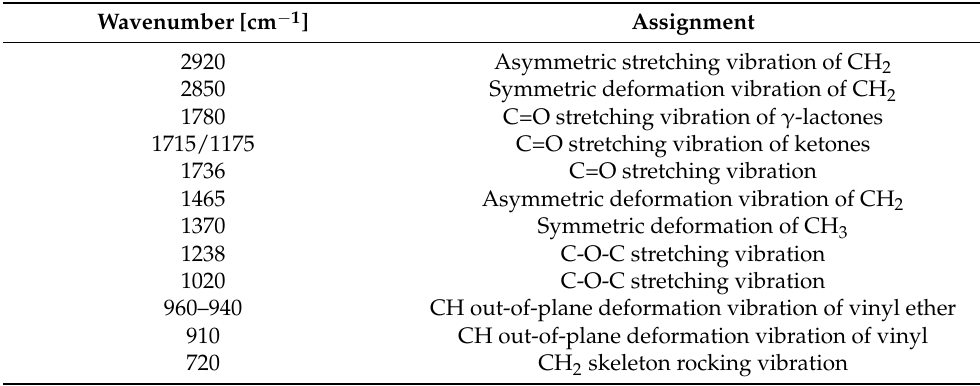
Table 4. Assignment of FT-IR bands in EVA spectra.